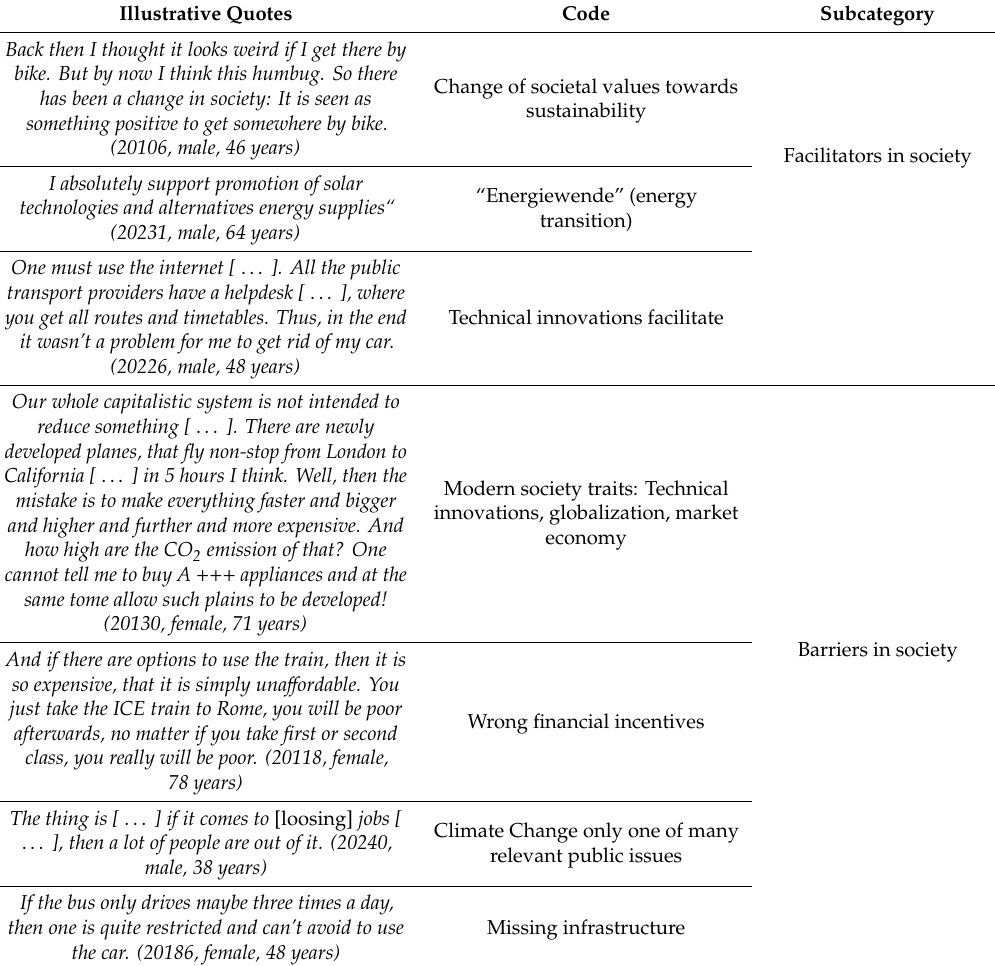
Table 7. Quotes, codes and sub-categories for the category “Societal